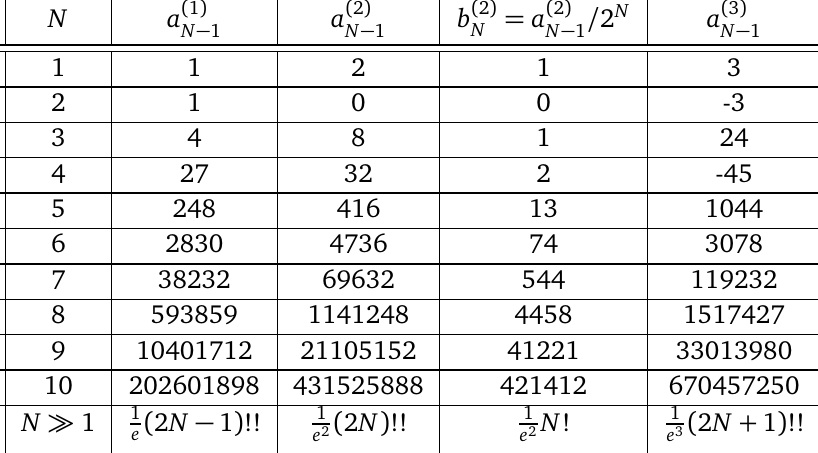
Table 1: Expansion coefficients for the self-energy dependence on the bold GF for d = 1,2,3